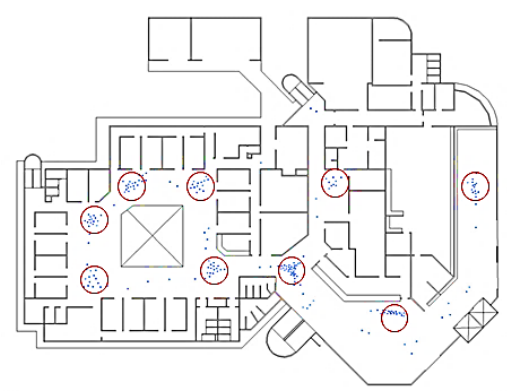
Table 3. Summary of the data recorded from the Ruka 2nd VR. Average Time Average Distance Stdv. Task No. (Meter) (Meter) Average Time Task No. Distance Stdv. (Meter) (Meter)